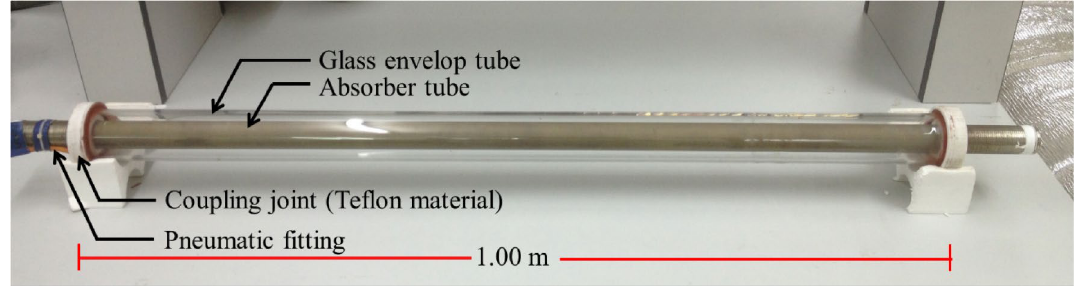
Fig. 1 The components of the solar receiver tube